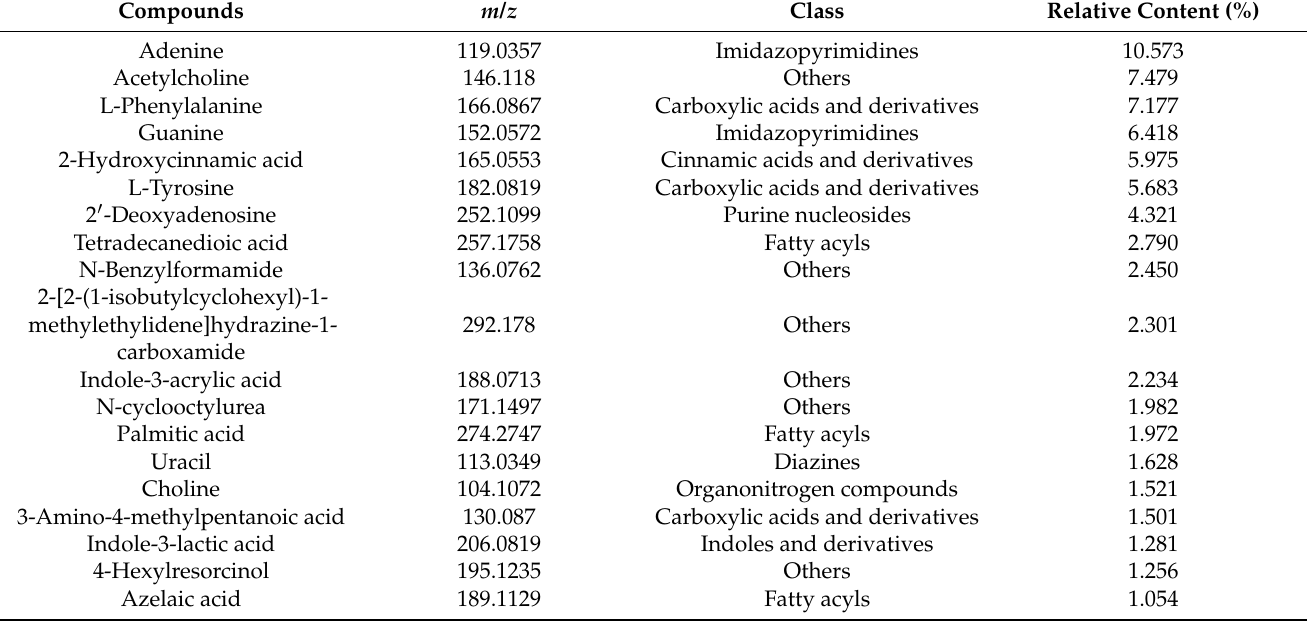
Table 1. Compounds with a relative proportion higher than 1% in YE4-CFE with a molecular weight of less than 3 kDa by